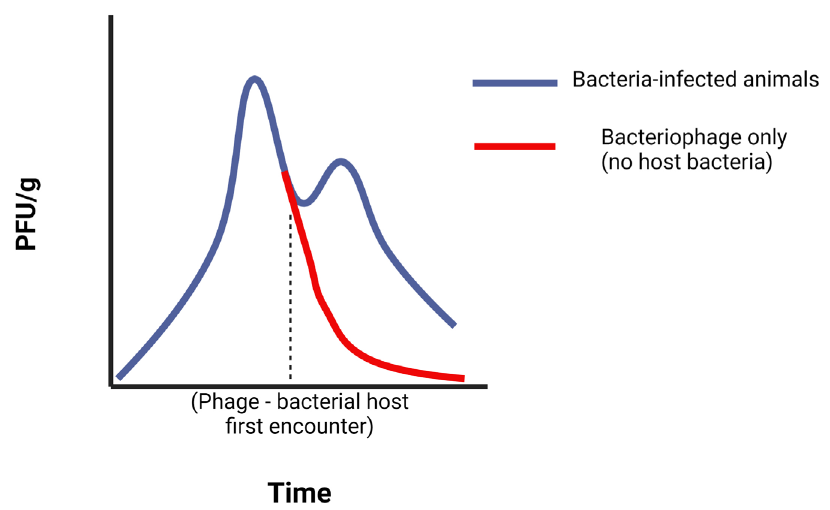
Figure 2A. Conceptual model of the effect of bacterial infection on phage (Φ) kinetics in blood and tissues. When phage encounter their bacterial hosts (bh) in infected animals, they replicate, and therefore require a longer time to be cleared from the system, in comparison to that of uninfected animals, where there are no bacteria that phage can infect. This self-replication property extends their therapeutic effect, as it leads to higher titers in tissues and blood, potentially leading to a reduced need for many doses, when compared with conventional antibiotics.